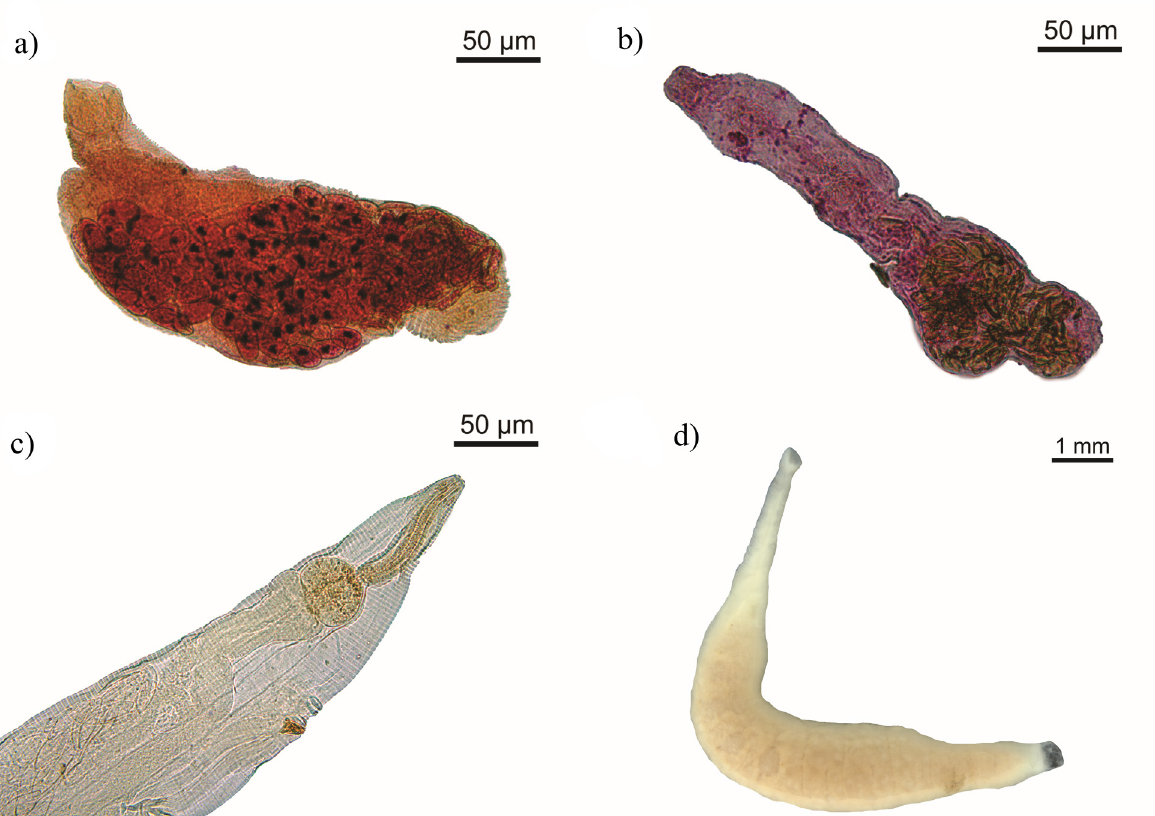
Figure 4. A selection of the parasites found in M. curema from the Cabedelo region, state of Paraíba, Brazil. a) Bucephalidae gen. sp., b) Fellodistomidae gen. sp., c) Pharyngodonidae gen. sp., d) Piscicolidae gen.